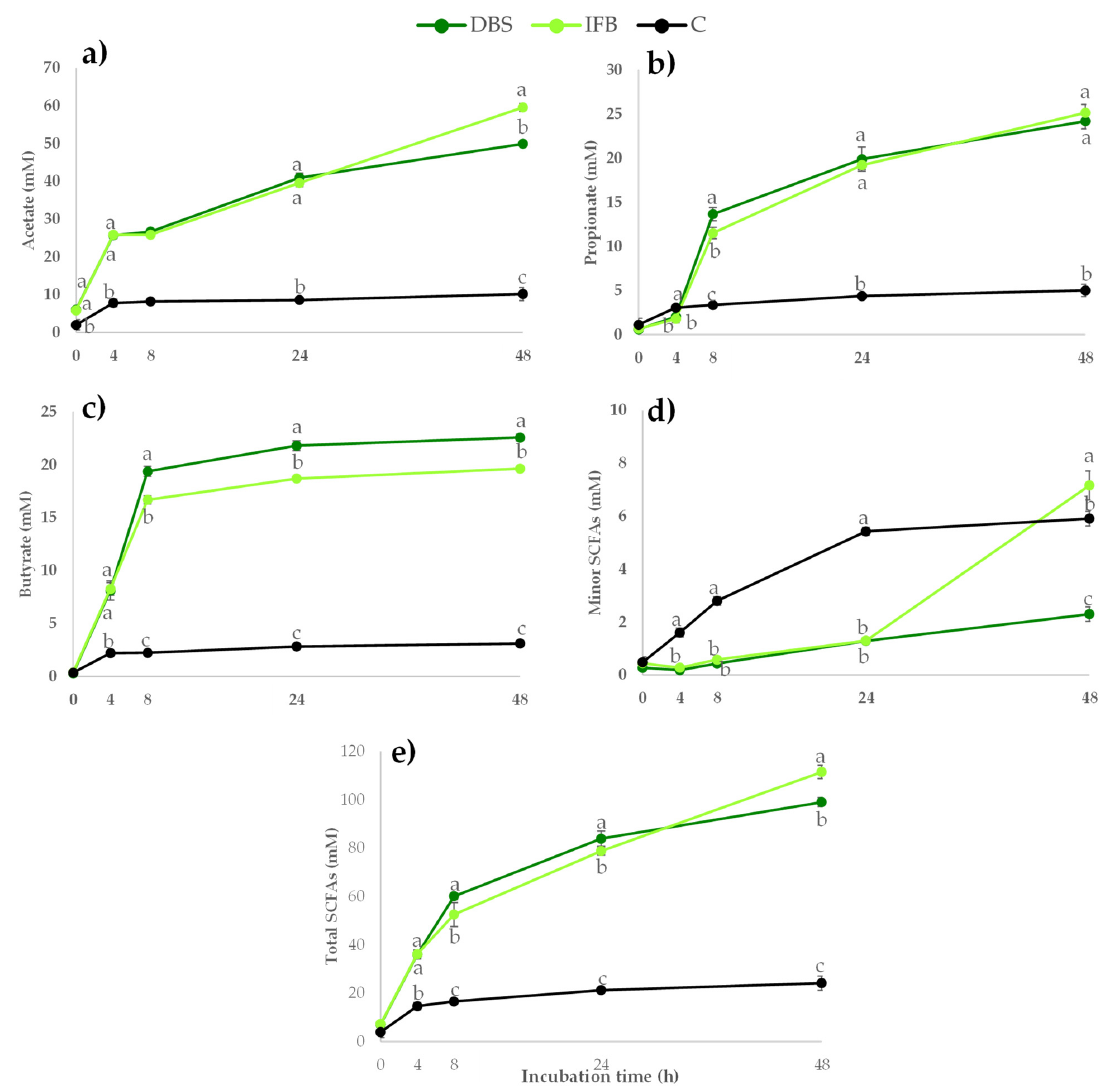
Figure 3. SCFAs production (acetate ( a ), propionate ( b ), butyrate ( c ), other minor SCFAs (isobutyrate, isovalerate, valerate, isocaproate, caproate and heptanoate) ( d ) and total SCFAs ( e )) (mM) during in vitro fermentation of samples obtained from broccoli stalk. Freeze-dried broccoli stalk ( • DBS); the insoluble fibre fraction ( • IF B ); the control ( • C). Values are expressed as mean ± SD (n = 3). Different letters (a–c) indicate significant differences ( p < 0.05) among the samples at the same incubation time.